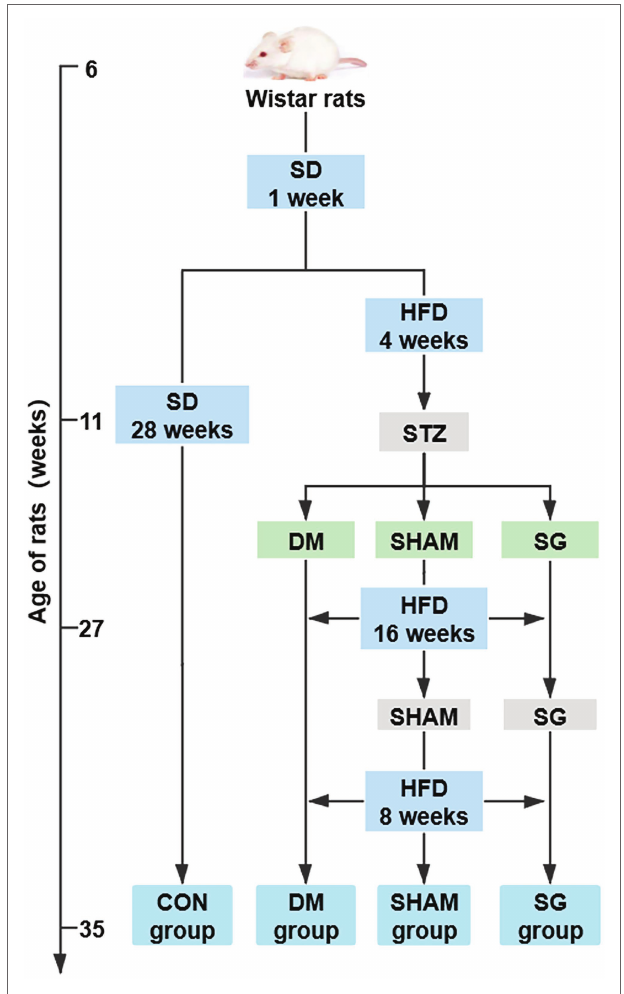
FIGURE 1 | The flow chart of animal experiments. N = 10 for per groups. SD, standard diet; HFD, high-fat diet; STZ, streptozotocin; CON, control; DM, diabetes mellitus; SHAM, sham operation; SG, sleeve